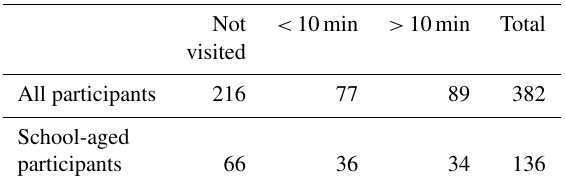
Table 4. Number of quiz